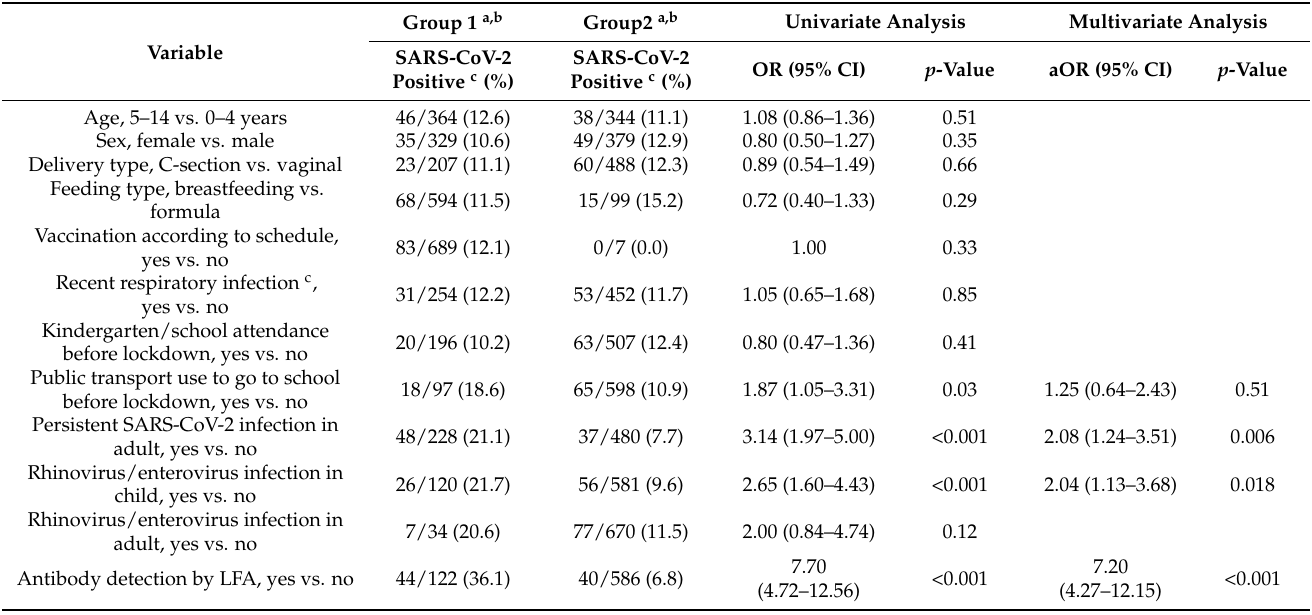
Table 3. Factors associated with persistent nasopharyngeal SARS-CoV-2 RNA detection in first-reported adult